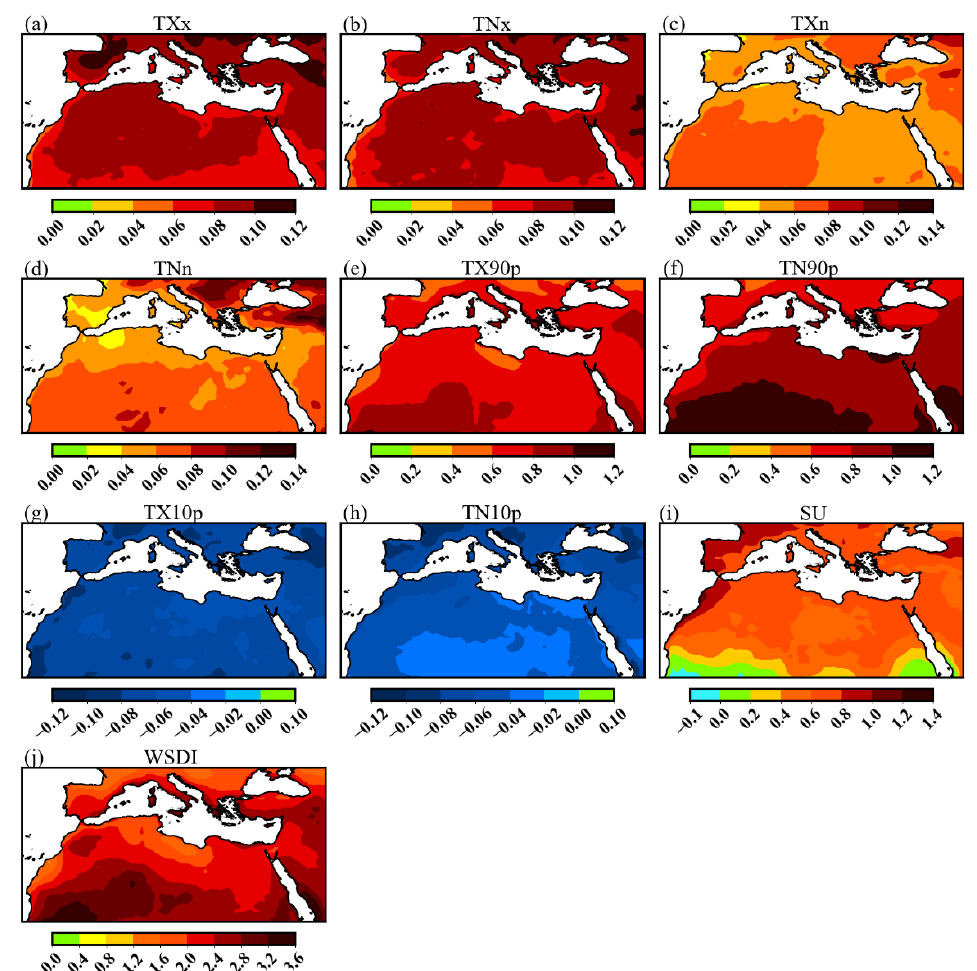
Figure 14. Same as Figure 13, but for the far-future (2071–2100).